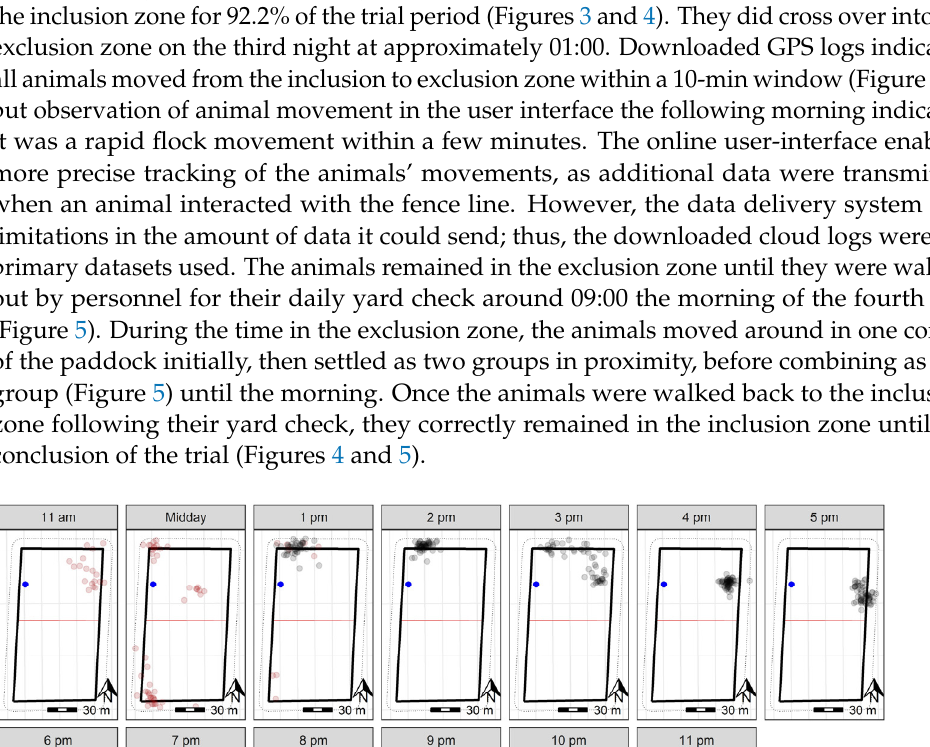
Figure 4. GPS plots per day for 10 sheep at Lameroo, with the water point within the inclusion zone indicated in blue. The grey points indicate the GPS positions (measured every 10 min) of individual sheep throughout the day. Darker points indicate point overlay in locations where sheep were reg- istered more frequently. The solid black rectangle indicates the wire fenced paddock boundary, with the red line representing the virtual fence. The dashed lines on the outside of the paddock boundary indicate the 10 m buffer zone used to clip the data to remove recording errors based on GPS drift. These plots do not include the initial training period on day one that is displayed in Figure 3. A scale is included to indicate paddock size.